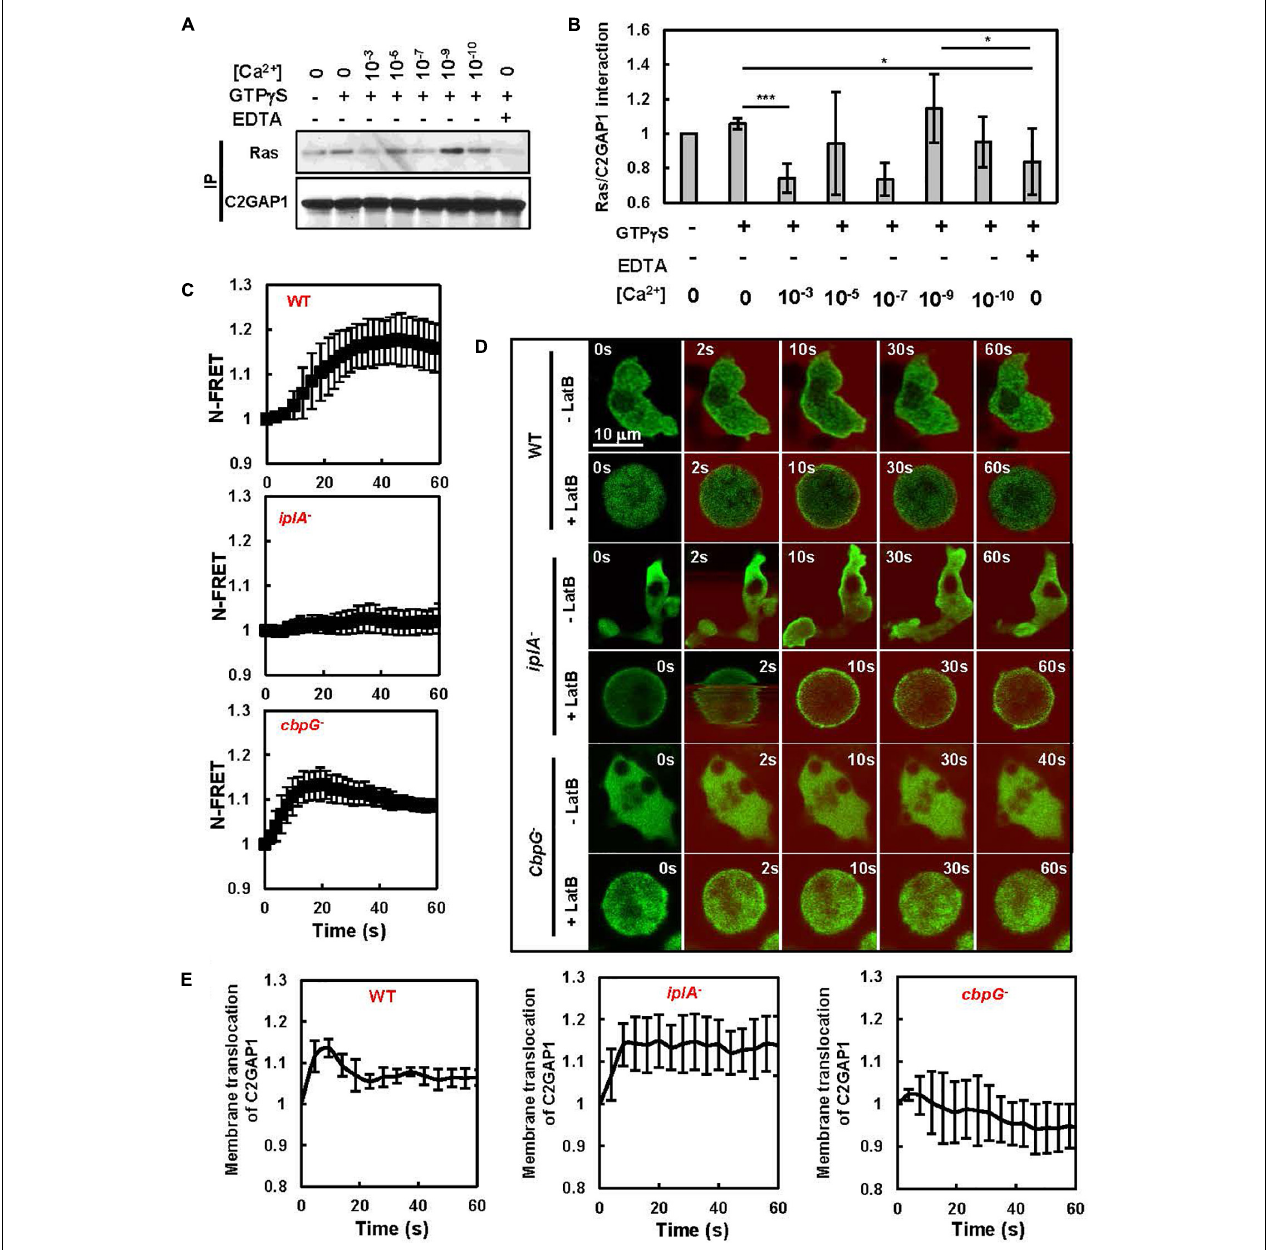
FIGURE 1 | [Ca 2 + ] is dynamically involved in the membrane targeting of C2GAP1. (A) High [Ca 2 + ] decreases the association of C2GAP1-YFP and Ras determined by co-immunoprecipitation (co-IP). Cells expressing C2GAP1-YFP were lysed in the presence or absence of GTP γ S (10 µ M), CaCl 2 at the indicated concentrations, or 2 mM EDTA and then subjected to IP assay and western blot detection of the indicated protein with their specific antibodies. (B) Quantitative measurement of C2GAP1 and Ras association presented in (A) . The ratio of Ras and C2GAP1 at time 0 s was normalized to 1. Mean ± SD from three independent experiments is shown. The p -values of Student’s t -test are indicated as * ( p < 0.1) and *** ( p < 0.001). (C) cAMP-induced calcium response in WT, iplA − , or cbpG − cells using calcium FRET sensor YC-Nano15. Cells expressing YC-nano15 were stimulated with 1 µ M cAMP at 0 s. To eliminate cell migration for quantitative measurement, cells were treated with 5 µ M Lat B for 10 min prior to the experiment. Calcium response was measured by sensitized emission FRET using a Zeiss 780 fluorescent microscope, analyzed using Zen software, and then graphed with Microsoft Excel. The FRET signal (N-FRET) at time 0 s was normalized to 1. Mean ± SD is shown; n = 7, 8, or 8 in WT, iplA − , or cbpG − group, respectively. (D) Montage shows cAMP-induced membrane translocation of C2GAP1-YFP (green) in WT, iplA − , or cbpG − cells in response to homogeneously applied 10 µ M cAMP stimulation (red). cAMP-chemotactic cells expressing C2GAP-YFP (green) were stimulated with cAMP at time 0 s. To visualize the stimuli, cAMP was mixed with fluorescent dye Alexa 594 (red). Also see Supplementary Video 1 . (E) Quantitative measurement of membrane-bound C2GAP1-YFP upon exposure to a cAMP gradient is shown. The quantitative measurement of membrane translocation was measured from the cells treated with 5 µ M Lat B shown in (D) Membrane translocation of C2GAP1 was quantified by the decreased in the cytosolic intensity of C2GAP1. The cytosolic intensity at time 0 s was normalized to 1. Mean ± SD is shown; n = 5, 6, or 8 for the groups of WT, iplA − , or cbpG − cells, respectively.